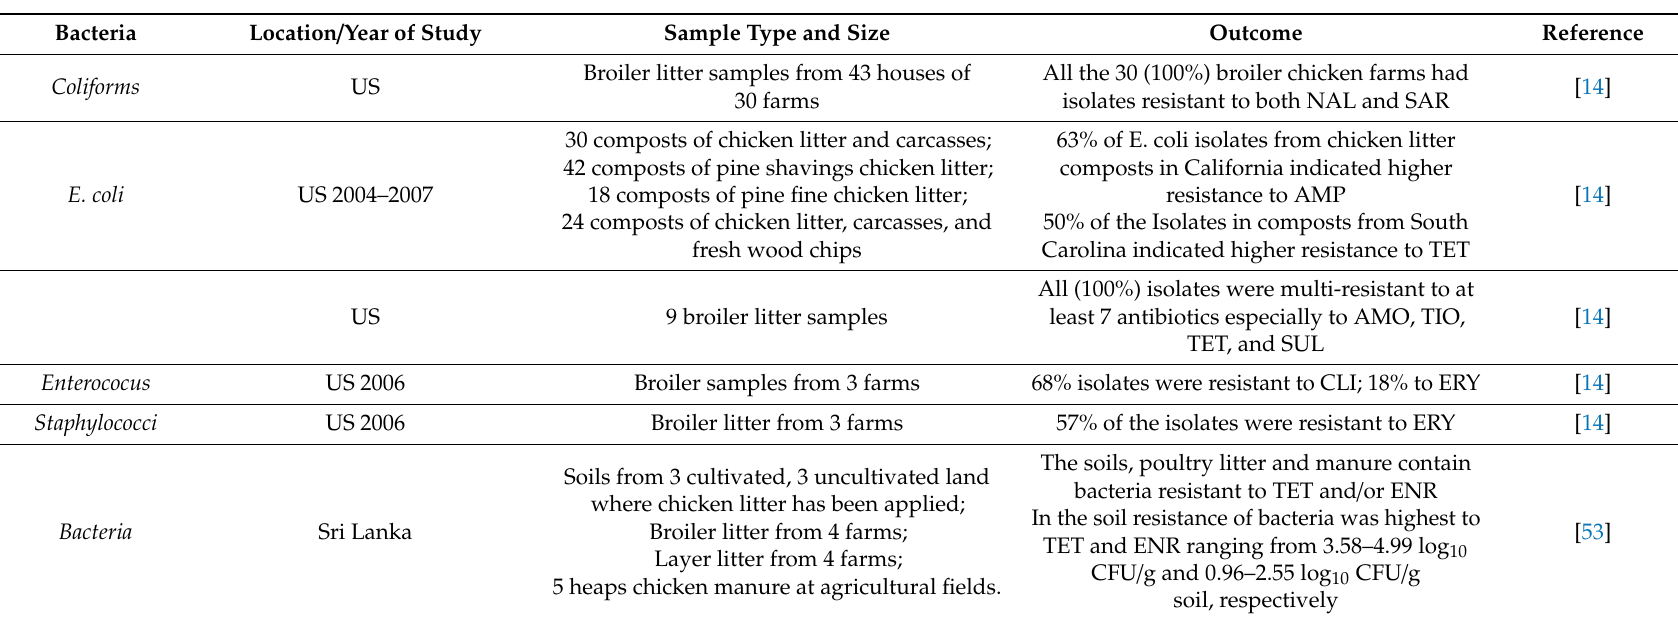
Table 3. Antibiotic-resistant bacteria in chicken litter or chicken litter-based organic